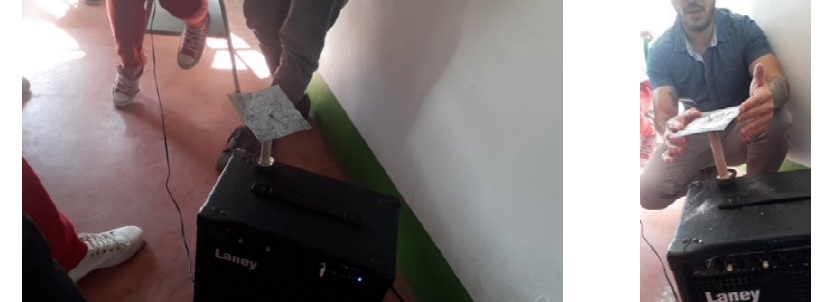
Figure 3. Chladni plate as art. A plate is installed on a speaker. The plate has flour on its surface and the vibrations generated by the speaker are transmitted to the plate, which makes multiple patterns. Left : students assembling the board with the amplifier and speaker, fixing the latter to a tube that transmits vibrations. Right : assembly ready for activity.